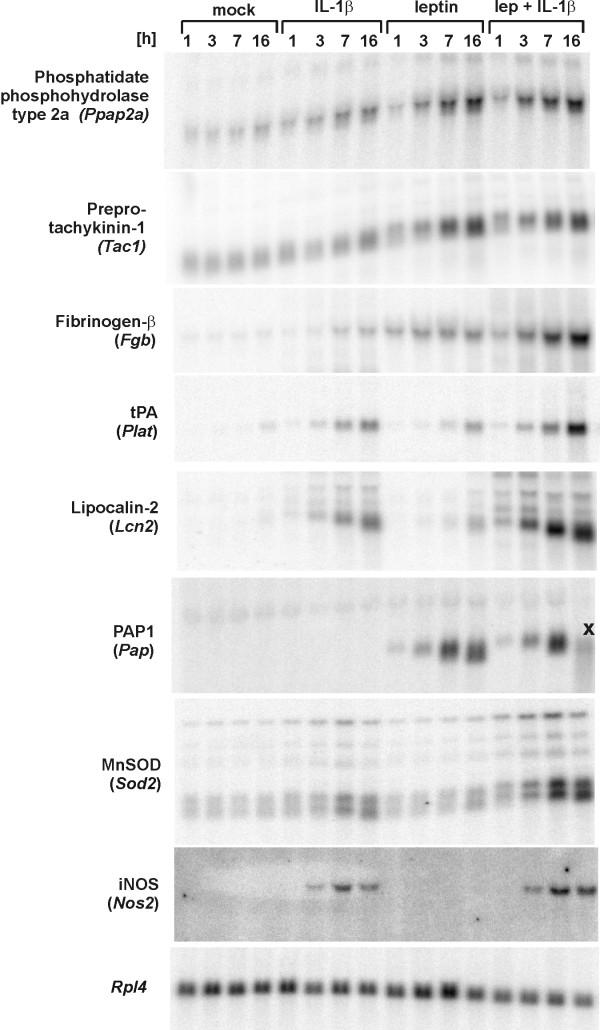
Effects of leptin and IL-1β on inflammation-related transcripts in RINm5F insulinoma cells. RINm5F cells stably expressing LEPRb were treated with leptin (100 ng/ml), IL-1β (50 u/ml), or a combination of both for the times indicated (1, 3, 7 or 16 h). Total RNA was isolated and subjected to Northern blot analysis with cDNA probes identified by differential hybridisation of the cDNA array (upper 6 panels, see table 1). iNOS and RPL4 serve as controls for an IL-1β-regulated mRNA and an unregulated mRNA, respectively. Gene symbols are shown in italics. A sample of degraded RNA on one of the blots is marked with an x.